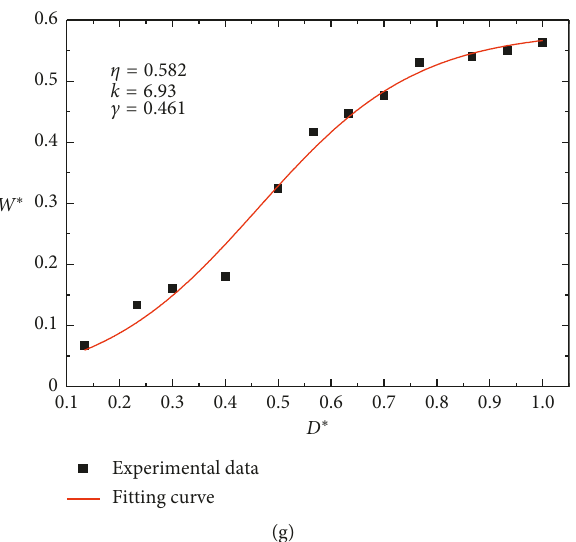
Figure 10: The relationship between the experimental data and fitting curves for W ∗ and D ∗ . The parameters η , k , and c in fitting equation (3) are shown in each figure. (a) Bed slope of 1 ° . (b) Bed slope of 2 ° . (c) Bed slope of 3 ° . (d) Bed slope of 7 ° . (e) Bed slope of 9 ° . (f) Bed slope of 11 ° . (g) Bed slope of 13 ° .